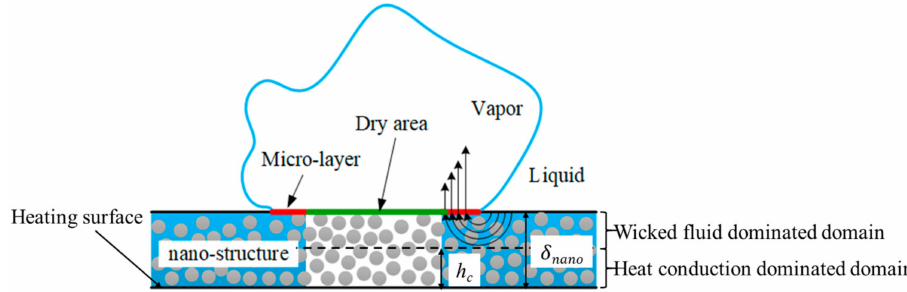
Figure 3. Schematic of the heat and mass transfer through